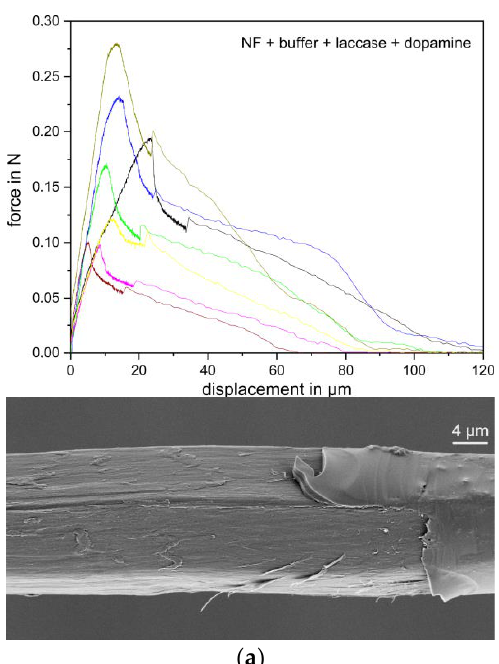
Figure 7. Top: single fibre pullout data of ( a ) laccase+dopamine-treated flax fibres in epoxy matrix and ( b ) buffer only-treated fibres in epoxy matrices; bottom: SEM images of respective fibre after pullout. Each SEM micrograph shows the original fibre surface on the image right edge, and the exposed fracture surface of the fibre after pullout on the left and centre of the image.